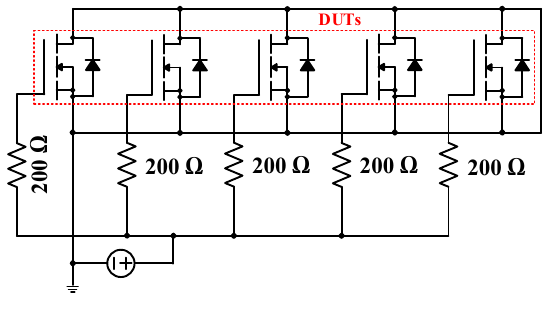
Figure 4. HEF stress circuit. Table 2. Datasheet values of switching devices used in this